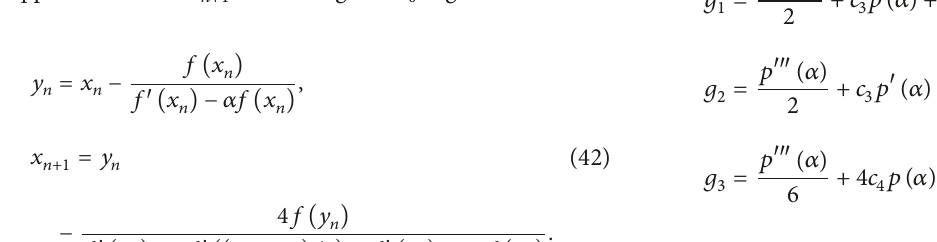
Algorithm 14. The iterative scheme which will compute the approximate root 𝑥 𝑛+1 for initial guess 𝑥 0 is given